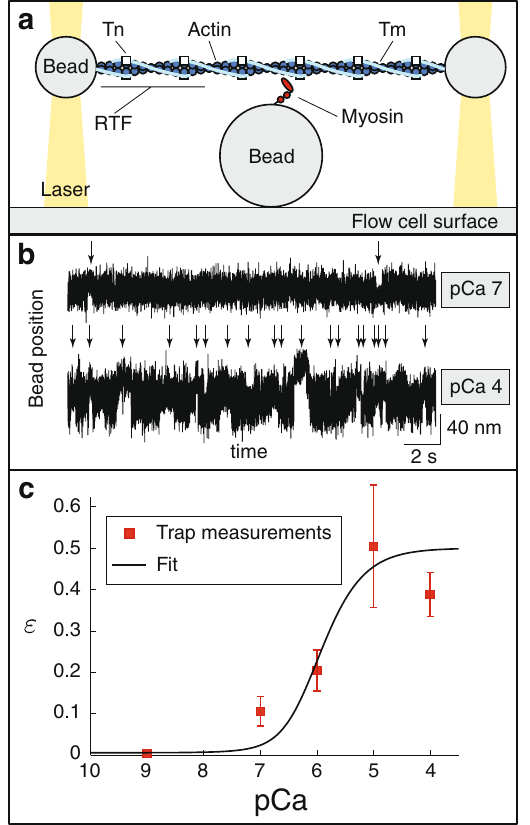
Figure 1. Direct measurements of the effect of Ca ++ on the rate at which a single myosin molecule binds to a regulated thin filament (RTF). ( a ) Cartoon of the single molecule laser trap (not to scale). ( b ) Raw data, showing the position of one of the laser-trapped beads as a function of time. Binding events, indicated with a vertical arrow, are much less frequent at low Ca ++ (pCa 7) than at high Ca ++ (pCa 4). ( c ) Event frequency, scaled by the event frequency in the absence of regulation (2.2 s − 1 ) as a function of Ca ++ is well-fit by equations (1) and (2), with K = 0.216 μ M. Symbols indicate mean frequency, error bars show standard deviation. The data point at pCa 9 is from ref. 28. ATP concentration is 1 μ